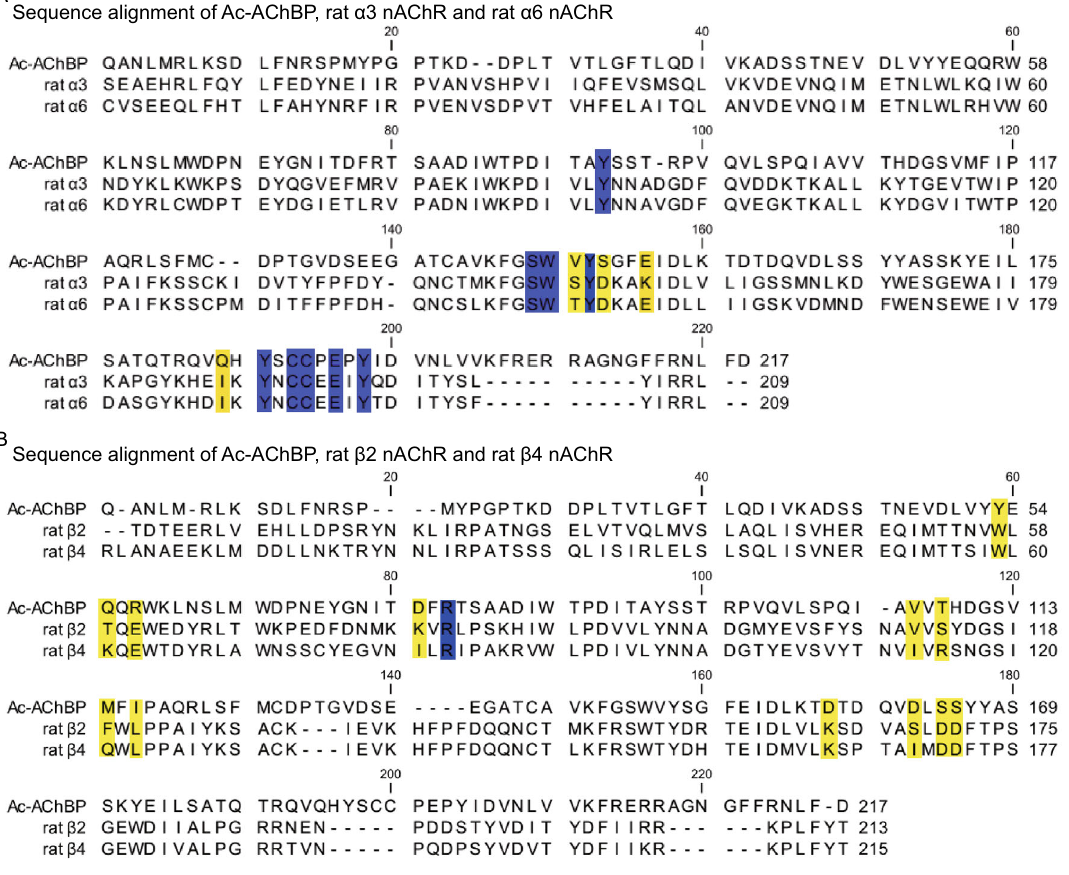
Figure 3. Primary sequence comparison of Ac-AChBP, and the rat α 3, α 6, β 2, and β 4 nAChRs. (A) Sequence alignment of Ac- AChBP, rat α 3 nAChR, and rat α 6 nAChR; regions colored yellow indicate the amino acids that are not conserved between the α 3 and α 6 ligand binding sites, regions colored blue indicate the amino acids that are conserved between the Ac-AChBP, α 3 nAChR, and α 6 nAChR ligand binding sites. (B) Sequence alignment of Ac-AChBP, rat β 2 nAChRs, and rat β 4 nAChRs; regions colored with yellow indicate the amino acids that are not conserved between the α 3 and α 6 ligand binding sites, regions colored blue indicate the amino acids that are conserved between the Ac-AChBP, β 2 nAChR, and β 4 nAChR ligand